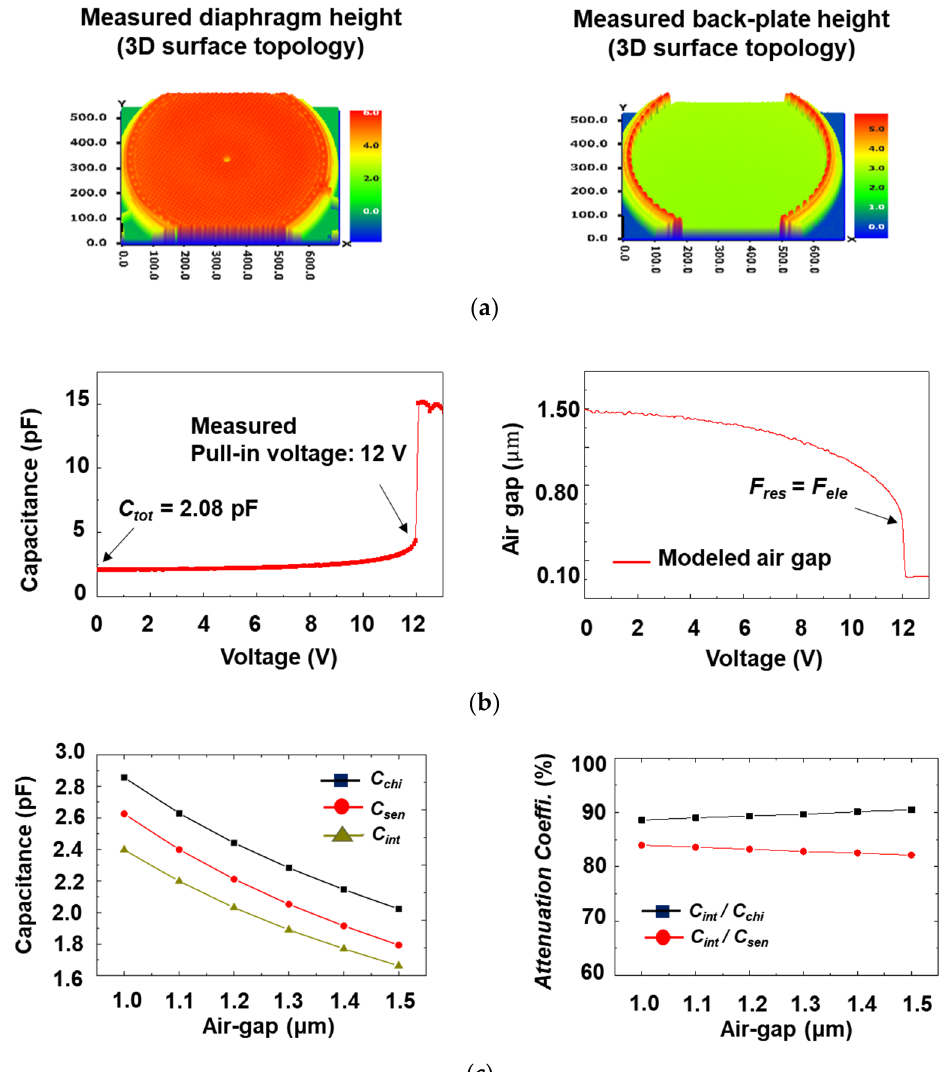
Figure 6 . ( a ) Diaphragm and back-plate height of capacitive MEMS acoustic sensor measured by 3D surface analyzer; ( b ) the pull-in voltage according to the capacitance-voltage measurement and the air gap on the applied voltage of a modeled capacitive MEMS acoustic sensor; ( c ) modelled sensor chip capacitances, active area capacitances, intrinsic capacitance for the air gap and the intrinsic component ratio of the sensor chip to the air gap and the intrinsic component ratio of the active